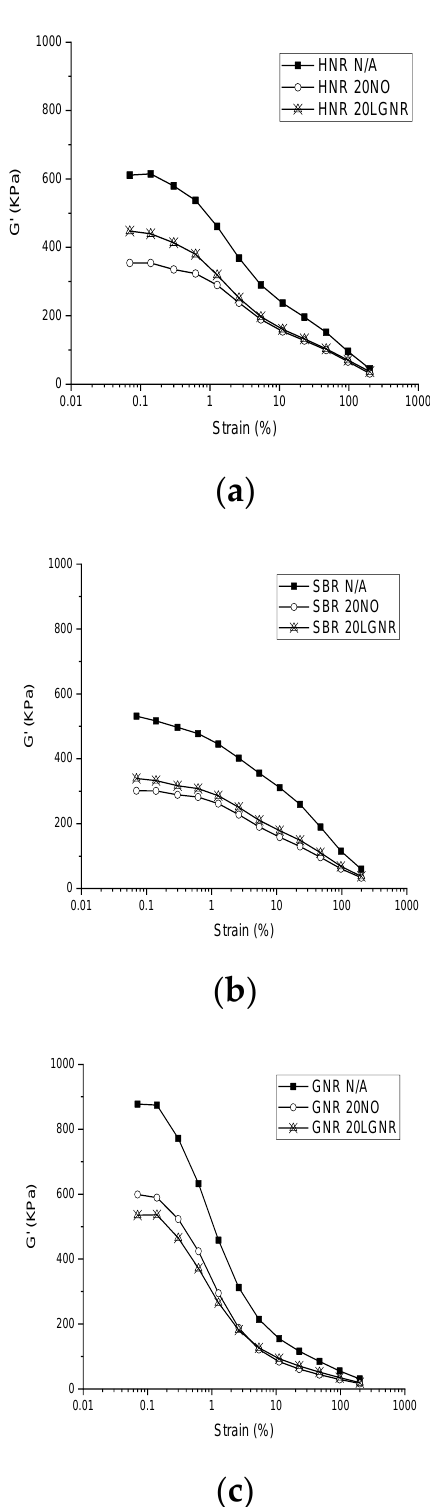
Figure 1. Storage modulus (G’) of rubber composites made with or without processing aids from 0.07% to 200% strain amplitude: ( a ) Hevea natural rubber (HNR); ( b ) styrene butadiene rubber (SBR); ( c ) guayule natural rubber (GNR). N/A: rubber compounds without processing aids; 20 NO: rubber compounds with 20 phr naphthenic oil; 20 LGNR: rubber compounds with 20 phr liquid guayule natural rubber.